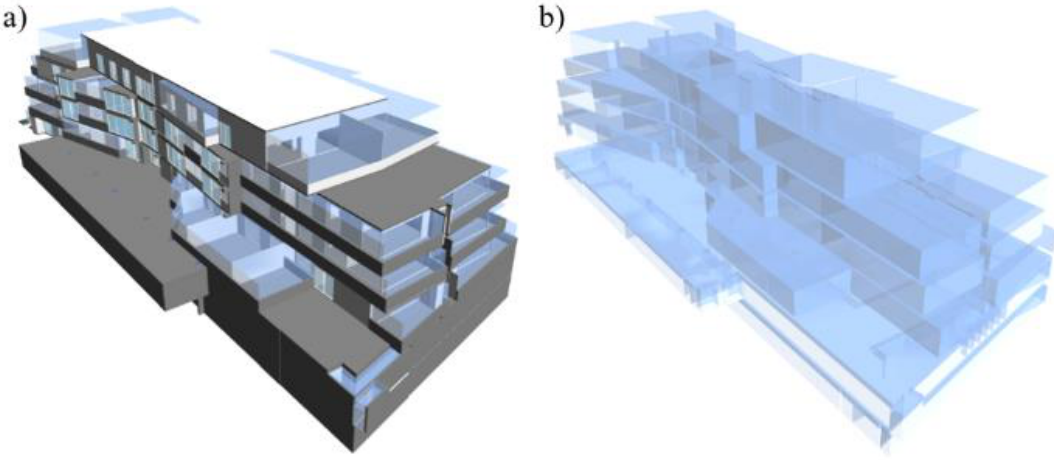
Figure 4. ( a ) The entire BIM model comprising physical objects and legal spaces and ( b ) all the legal spaces in the BIM model .